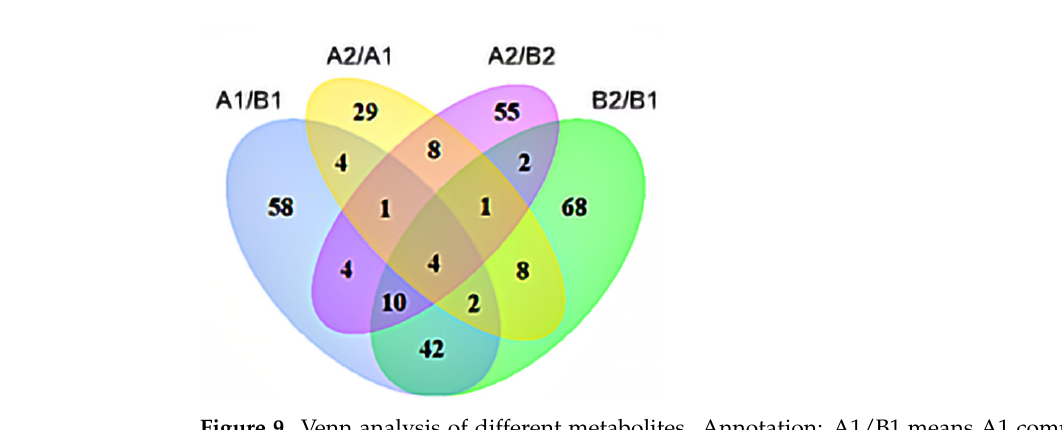
Figure 9. Venn analysis of different metabolites. Annotation: A1/B1 means A1 compared to B1; A2/B2 means A2 compared to B2; B2/B1 means B2 compared to B1; A2/A1 means A2 compared to A1.